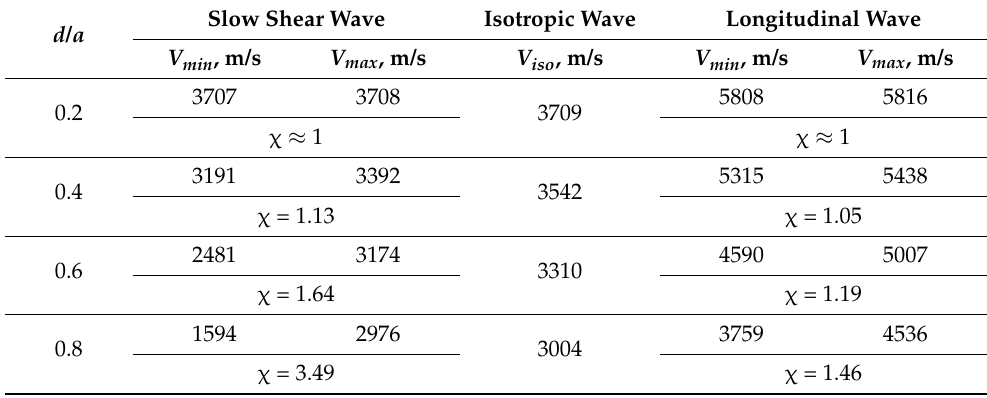
Table 1. Phase velocities of acoustic modes and their anisotropy coefficients for phononic crystals with various normalized hole